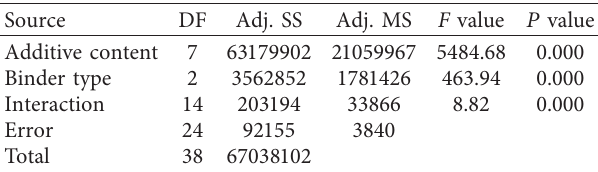
Table 14: Two-way ANOVA: rut depth versus additive and binder type. Source Interaction